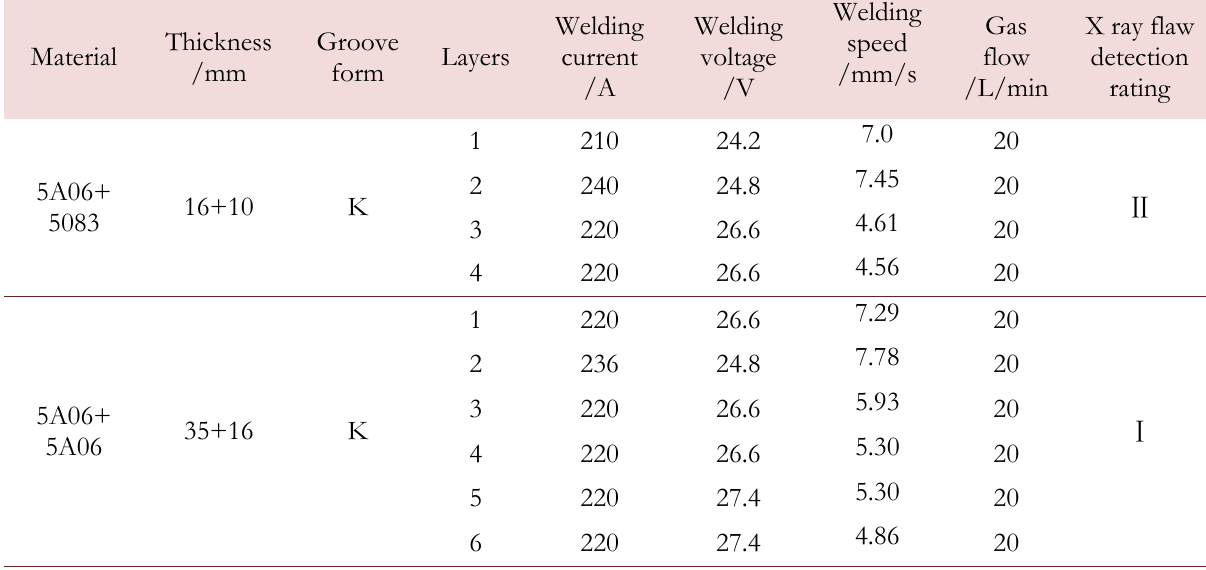
Table 5: Welding parameters of T-welded joints.